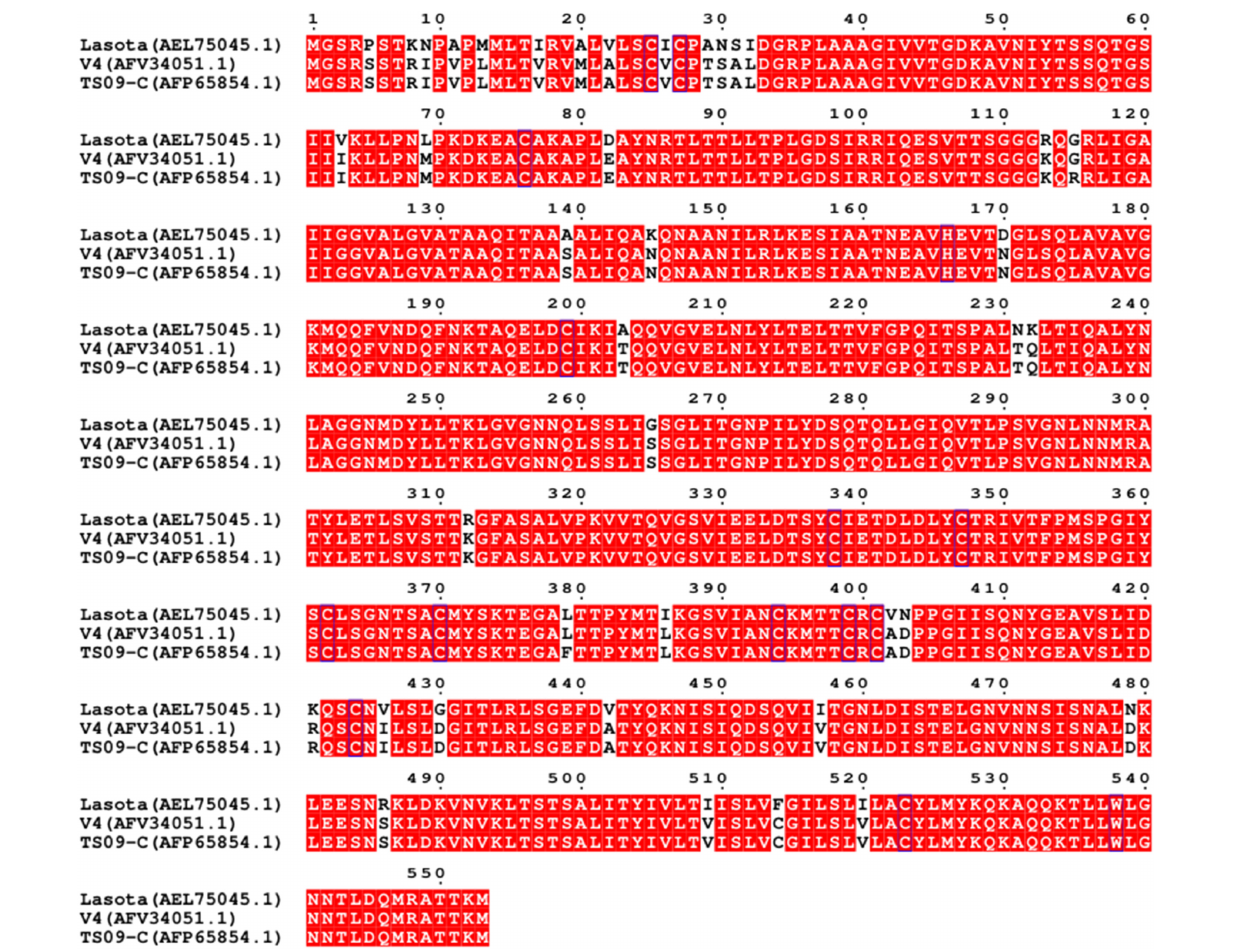
FIGURE 1 | Amino acid sequence alignment of the F proteins of NDV strains LaSota, V4, and TS09-C. The amino acid sequence alignment of F proteins from NDV strains LaSota, V4, and TS09-C was constructed at the website ESPript 3.0 (https://espript.ibcp.fr/ESPript/cgi-bin/ESPript.cgi). The sites without red highlighting contain different amino